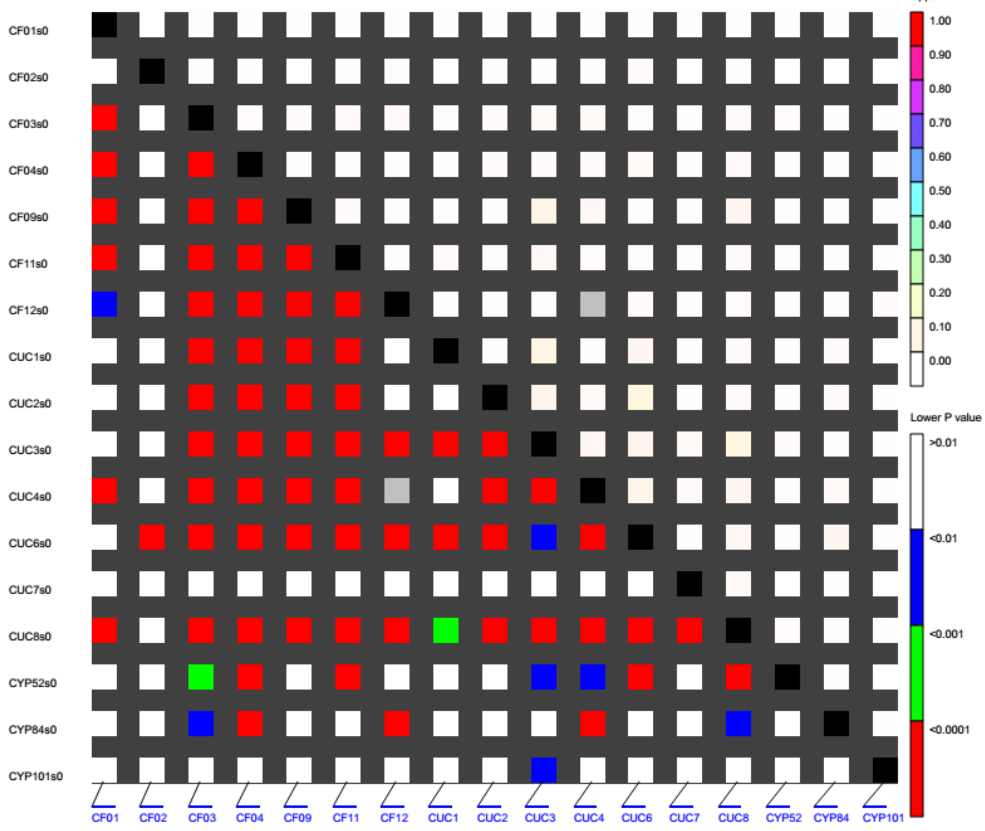
Figure 5. Pairwise linkage disequilibrium (LD) ( R 2 ) between simple sequence repeats (SSRs) in cypress.